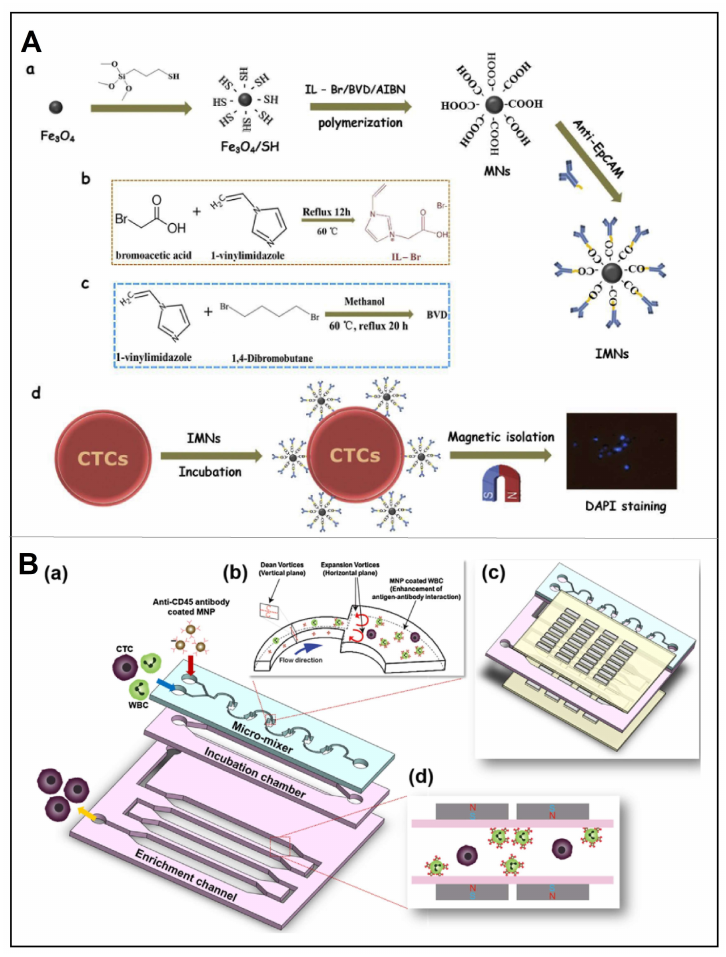
Figure 8. ( A ) Representation of CTCs captured by PIL-decorated IMNs. ( a ) Preparation of anti-EpCAM conjugated IMNs. ( b ) Synthesis of IL-Br. ( c ) Synthesis of 1,4-butanediyl-3,3 (cid:48) -bis-l- vinylimidazolium bromide (BVD). ( d ) Application of the PIL-decorated IMNs for CTCs capturing and isolation. Reproduced with permission from [76]. ( B ) Schematic diagram of a µ -MixMACS chip for one-step CTCs isolation. ( a ) Structure of the chip: a microfluidic mixer, an incubation chamber and a magnetic activated cell sorter (MACS). ( b ) In the microfluidic mixer, the interaction between CD45-conjugated MNPs and WBCs was enhanced. ( c ) Two magnetic sorters were placed at the top and bottom of the microfluidic mixer, respectively. ( d ) The µ -MixMACS chip was used to capture the MNP-coated WBCs via magnetic activation, thus eluting CTCs through the outlet. Reproduced with permission from